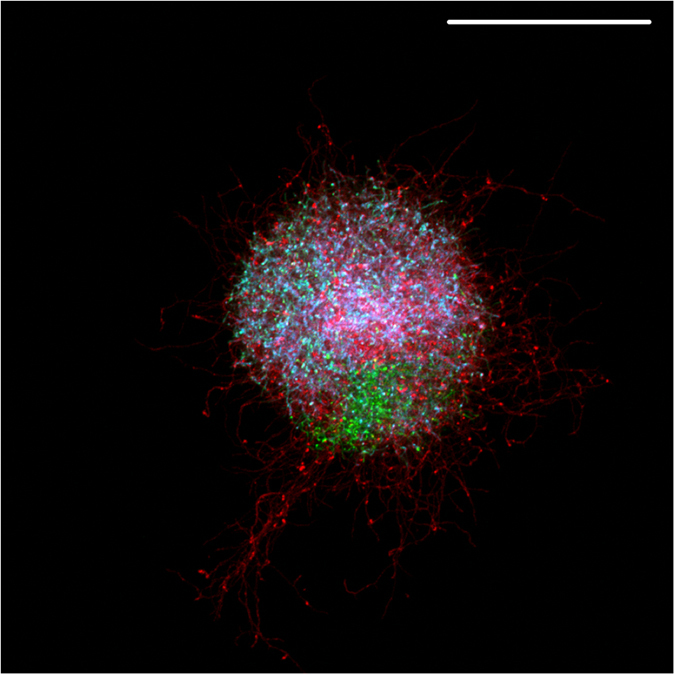
Formation of multi-species Streptomyces pellets.Germlings of S. coelicolor M512 (green), S. scabies (red) and S. lividans (false-colored in cyan) aggregate to form multi-species pellets. The image shows a representative pellet obtained after 24 h of growth of the three strain in NMMP medium. Scale bar represents 100 μm.